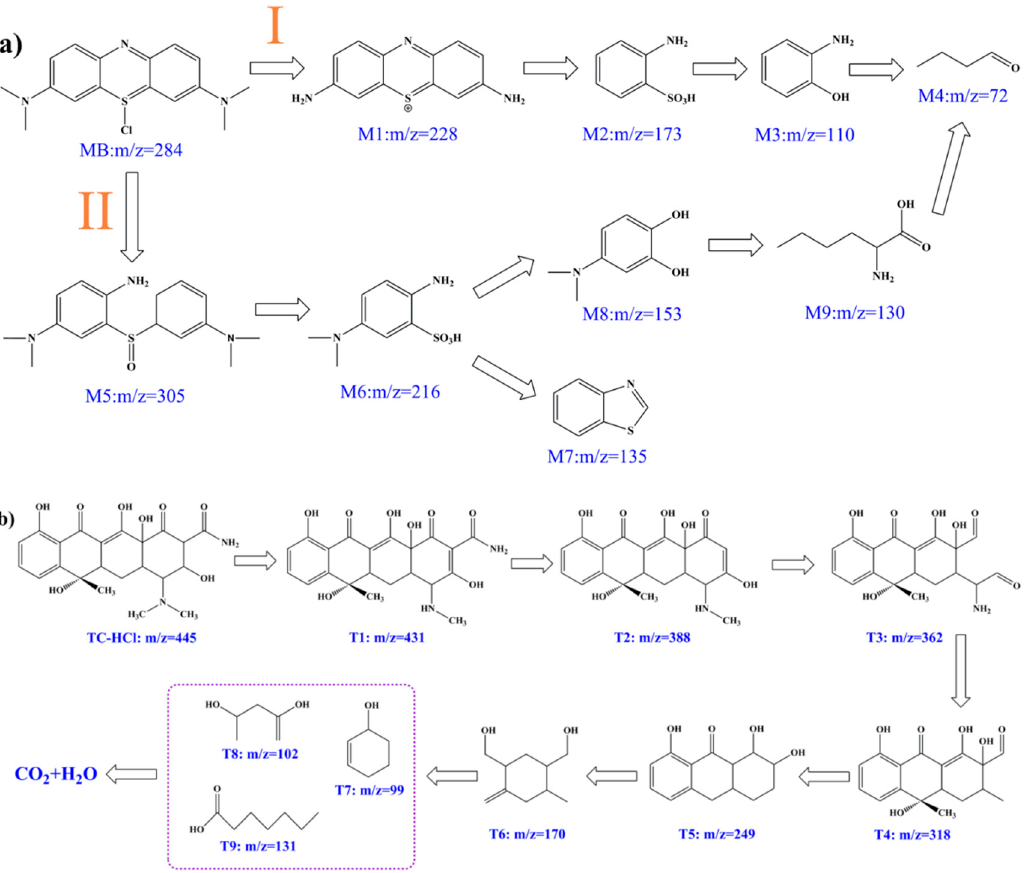
Figure 10. ( a ) The proposed photocatalytic degradation pathway of MB and ( b ) TC-HCl over